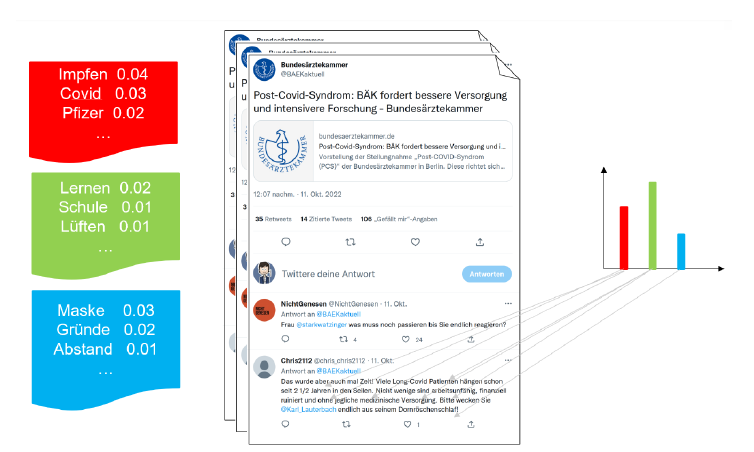
Figure 4. Principles of Topic Modeling including topics ( left ), documents and documents as topic mixtures ( right